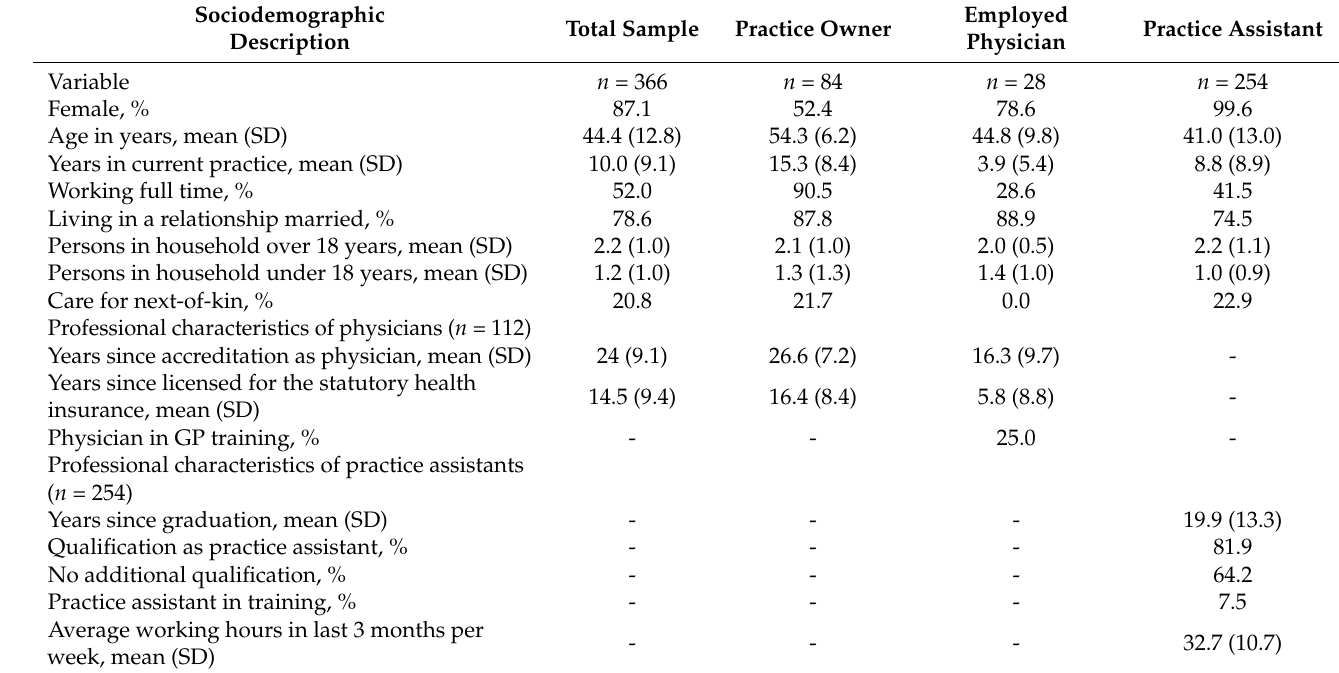
Table 1. Sociodemographic description of participants at